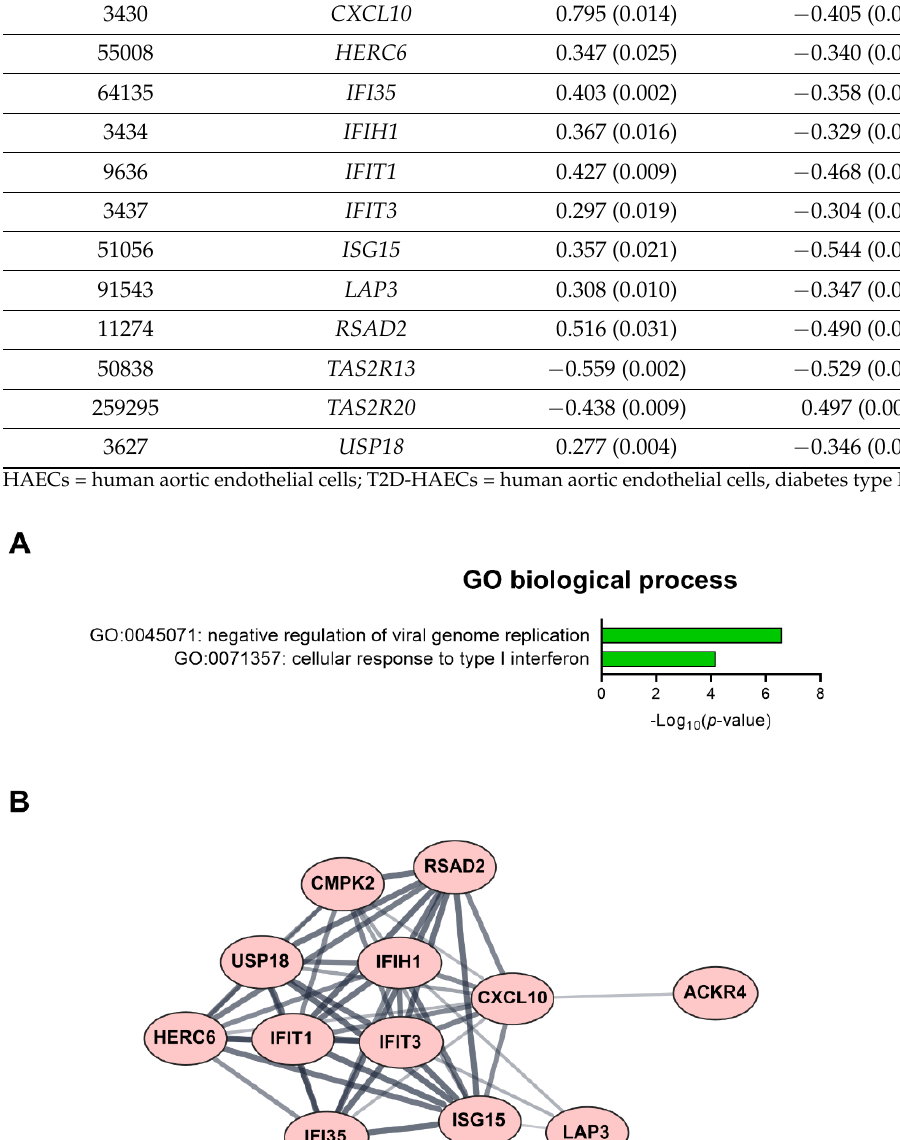
log 2 (fc) ( p -Value) HAECs T2D-HAECs